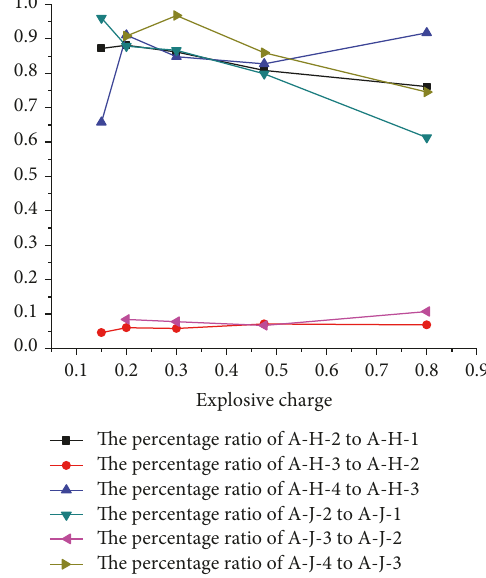
Figure 13: Percentage ratio of strain at each measurement point of Model 1.